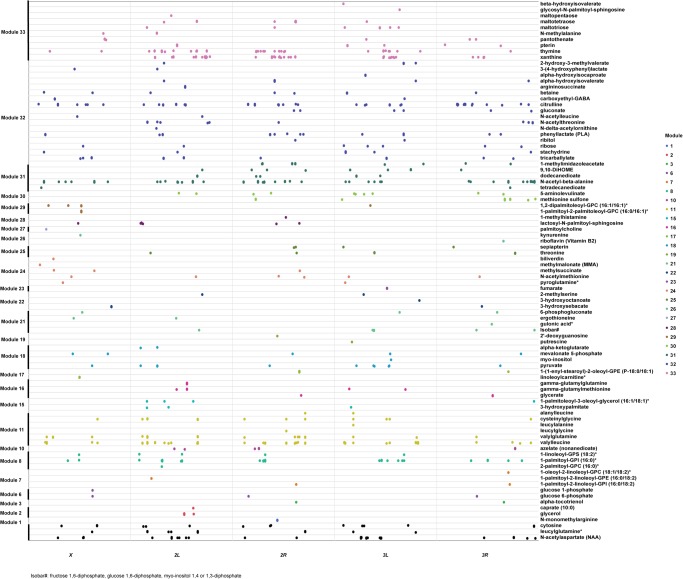
Polymorphic markers associated with variation in metabolites at a Bonferroni-corrected threshold of significance in males. Metabolites and polymorphic markers are ordered according to the modules identified in Figure 2 and color-coded. Black symbols represent polymorphic markers that are associated with metabolites that are not contained in modules.